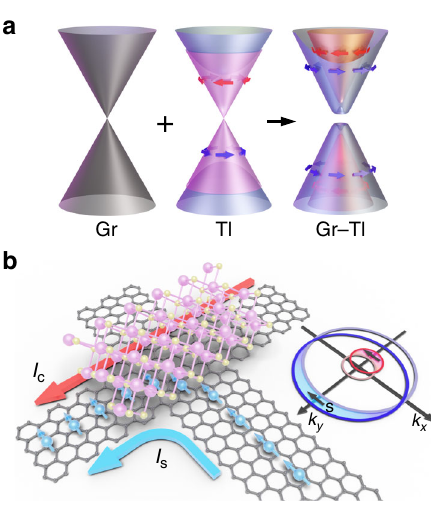
Fig. 1 Spin-galvanic effect in a graphene-topological insulator heterostructure. a Schematics of band structures of pristine graphene (Gr), topological insulator (TI), and a Gr – TI heterostructure. Due to proximity- induced spin – orbit interaction (SOI), graphene develops Rashba spin-split bands and acquires a spin texture that is different from the spin texture of the TI surface states. b A schematic representing the spin-galvanic effect, where spin-polarized carriers diffuse in the Gr – TI heterostructure, acquire a transverse momentum and produce a charge current. The inner and outer Fermi circles of spin-split proximitized graphene bands shift in opposite directions in the k-space, providing the carriers with a net momentum along a direction perpendicular to their